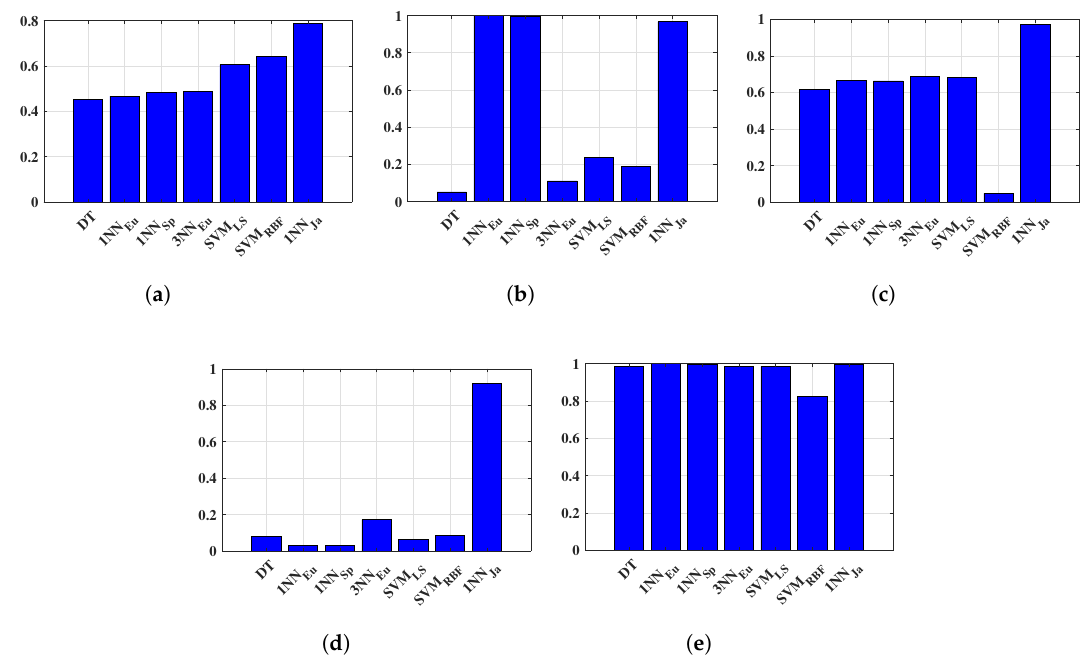
Figure 13. Comparison of proposed methods based on different statistical metrics: ( a ) accuracy; ( b ) true positive rate; ( c ) true negative rate; ( d ) positive predictive value; and ( e ) negative predictive